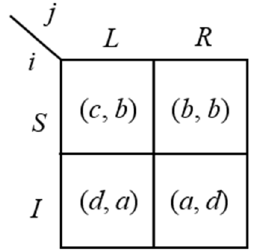
Figure 7. Original game G with multiple confirmed agreements.